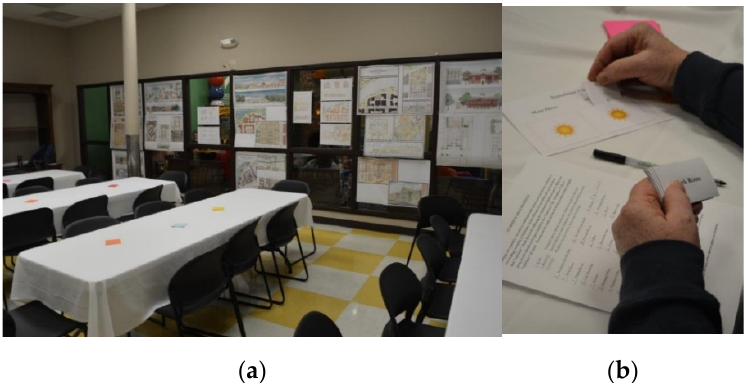
Figure 1 . Participatory design research exercise session set-up. ( a ) Six Clubhouse design proposals created by students were posted on the glass wall in front of four long folding tables. ( b ) A Club- house member completes the space prioritization exercise by sorting spaces according to whether they “must,” “should,” or “could” be included in a new Clubhouse. “must,” “should,” or “could” be included in a new